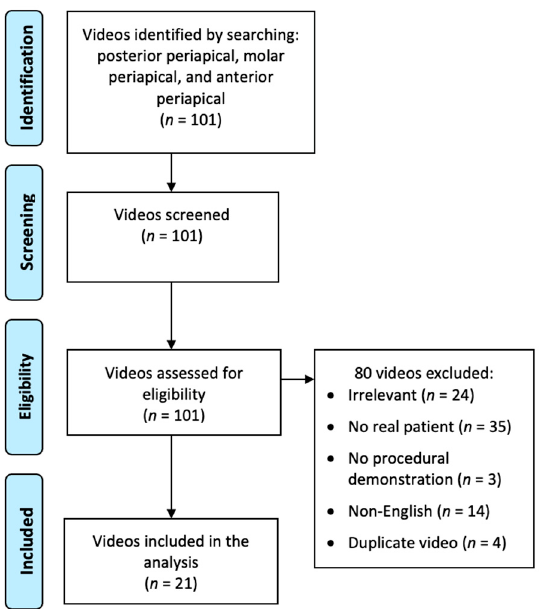
Figure 1. A flow chart showing the screening process of the YouTube videos.